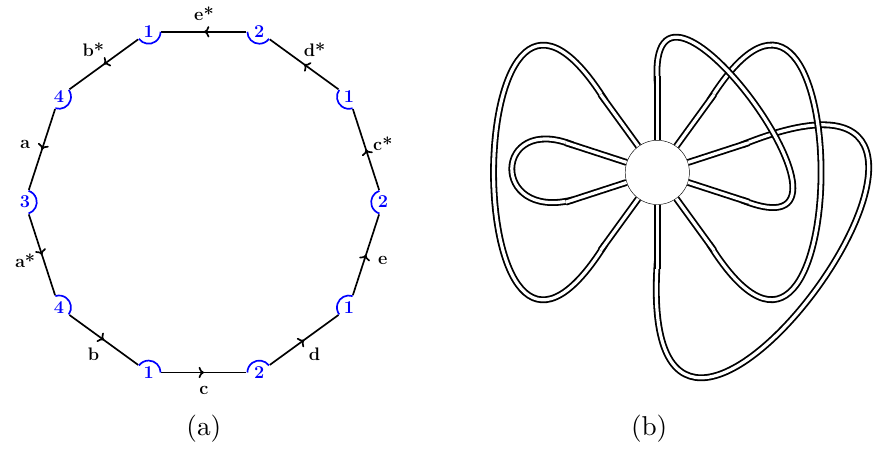
Figure 13 . The genus-one minimal graph of (cid:12)gure 12 represented as the polygon of its single face (a), and its dual represented by Wick contractions in a one-point matrix correlator